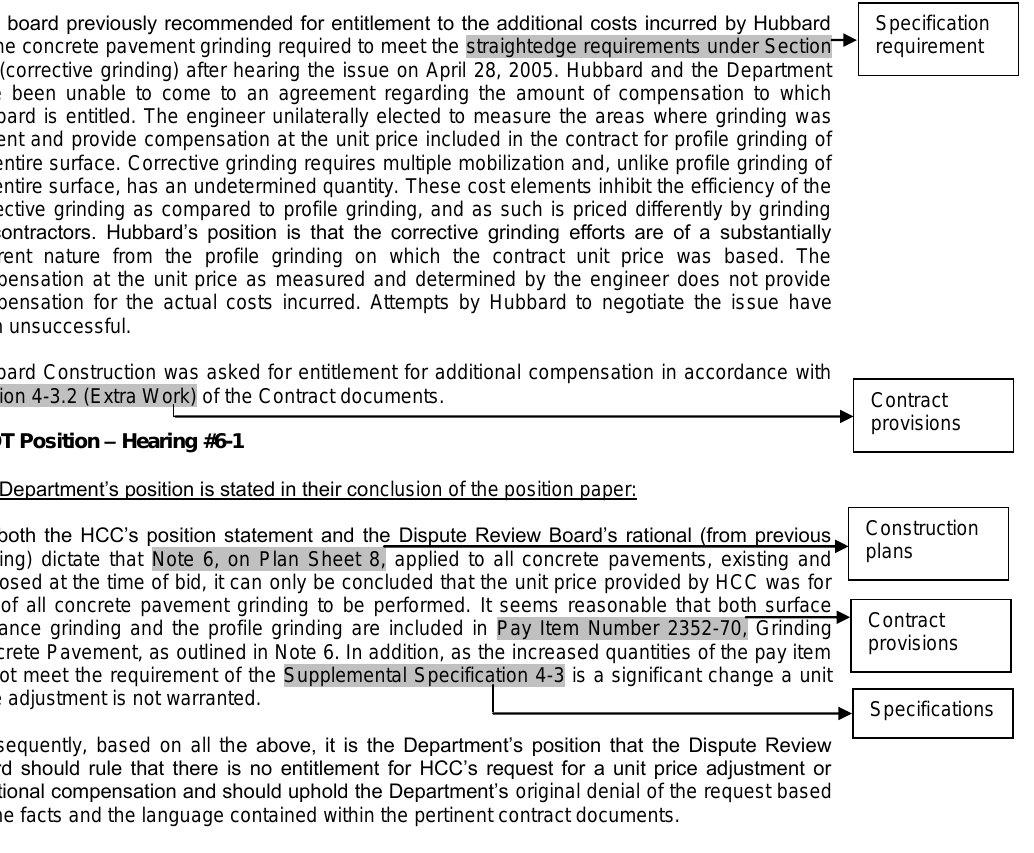
Fig. 7. Sample Positions of a DRB